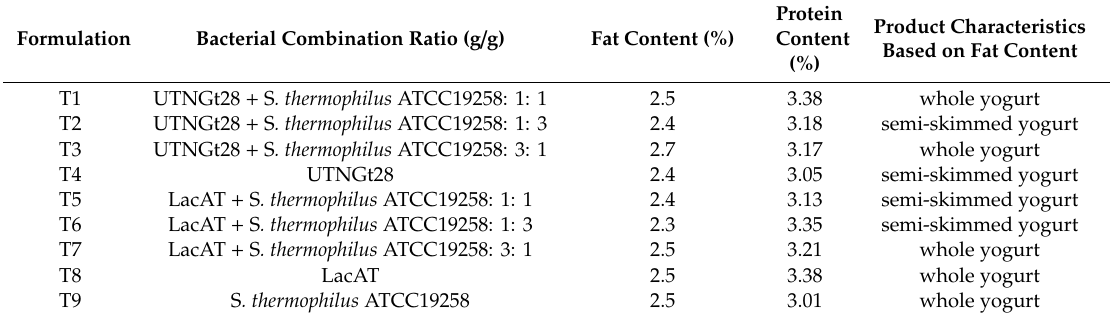
Table 4. Variation of fat and protein at day 28 of storage in the yogurt